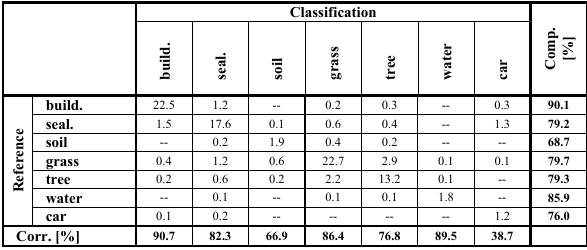
Table 1: Confusion matrix obtained by classification using the CRF approach with correctness (corr.) and completeness (comp.) values [%] for the land cover classes build. , seal. , soil , grass , tree , water and car . The class rails is omitted.